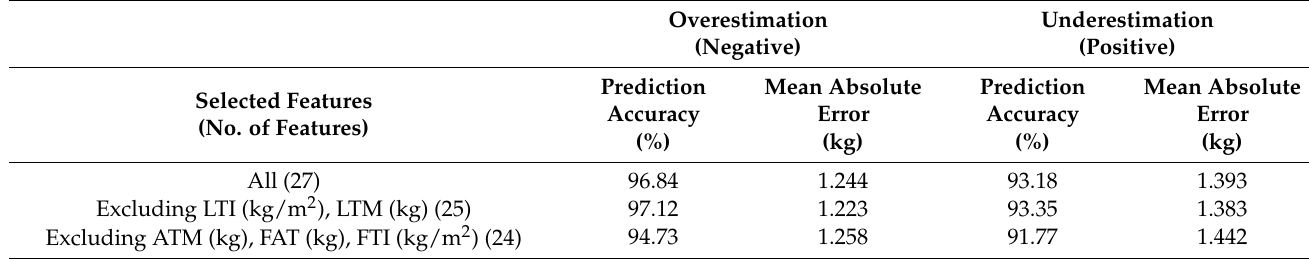
Figure 2. Comparison of clinical parameter by differences of DW CP-BIS . Table 4. Comparison of prediction accuracy of DW CP using linear regression by fat and muscle feature groups for − 15 kg < DW CP-BIS < 15